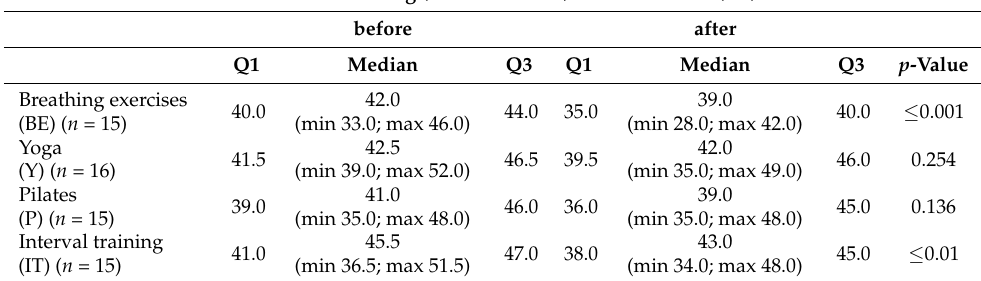
Table 6. Results of the trunk side bending (lateral flexion) test (cm) to the right side of the four groups (target BE programme and three other programmes: yoga, Pilates and dynamic interval training) before and after the training period. The students participated voluntarily in and were randomly assigned to training programmes. The duration of each training session was one hour, twice a week for 7 weeks.